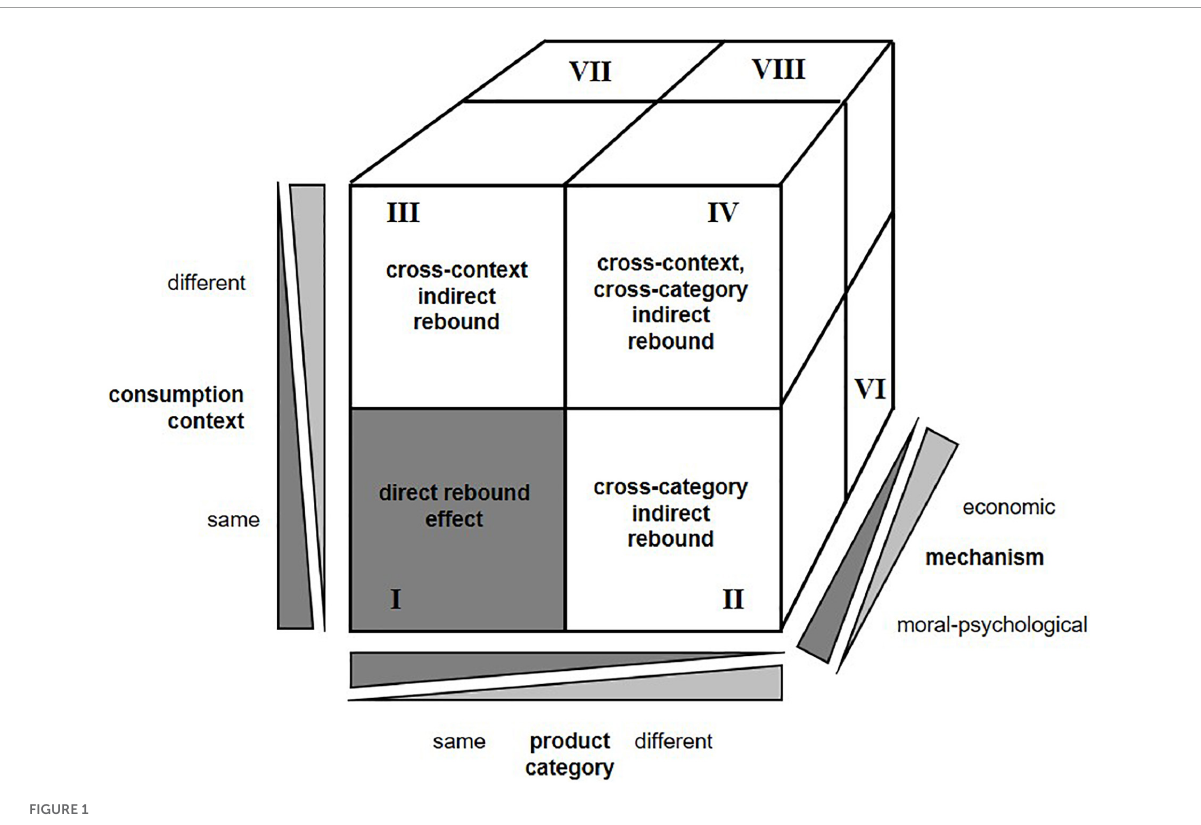
FIGURE1 Rebound